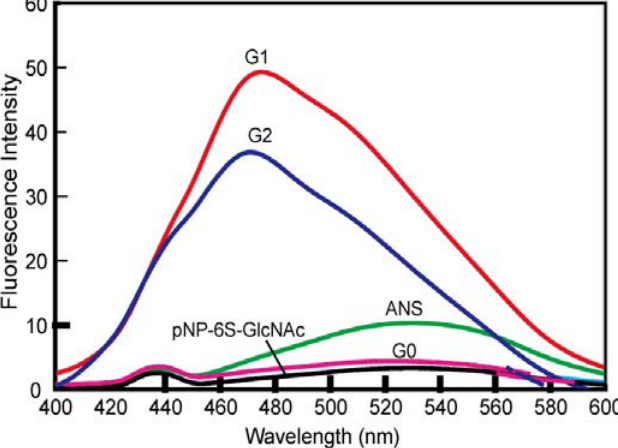
Figure 3. Fluorescence spectra of ANS (20 μ M) with sugar derivatives (66.7 μ M) in PBS